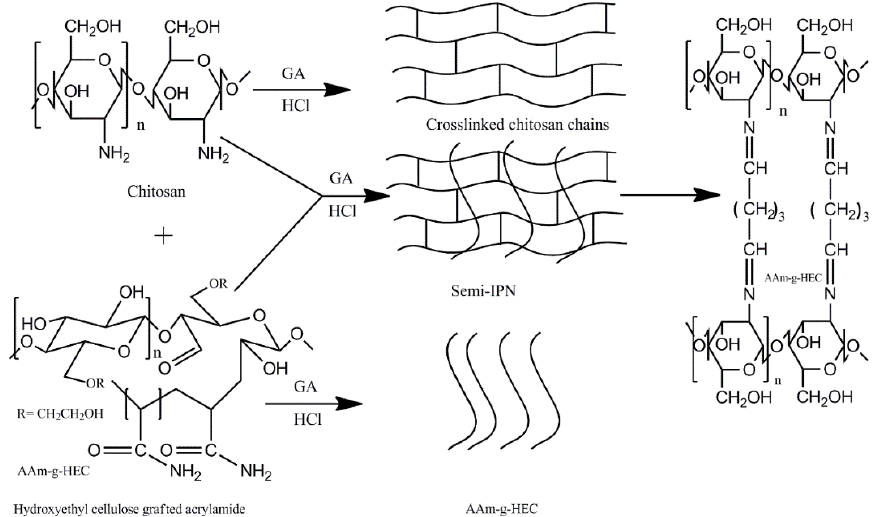
Figure 10. The proposed reaction mechanism of a semi-IPN hydrogel of chitosan/acrylamide-g-hydroxyethyl cellulose [100] .